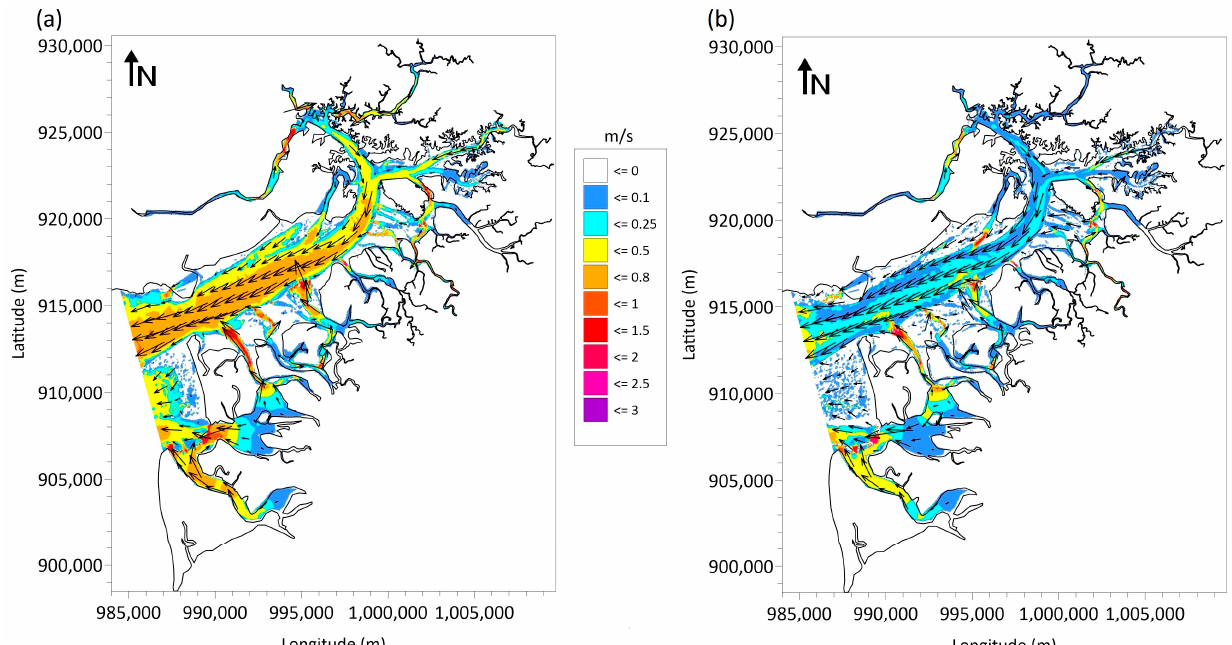
Figure 4. Modeled hydrodynamic field during ebb tide at surface layer (1 m below surface) for the: ( a ) highest Sizygy (29abr2021–00:00 h) and ( b ) the lowest Quadrature (22dic2021–14:00 h) in Buena- ventura Bay.